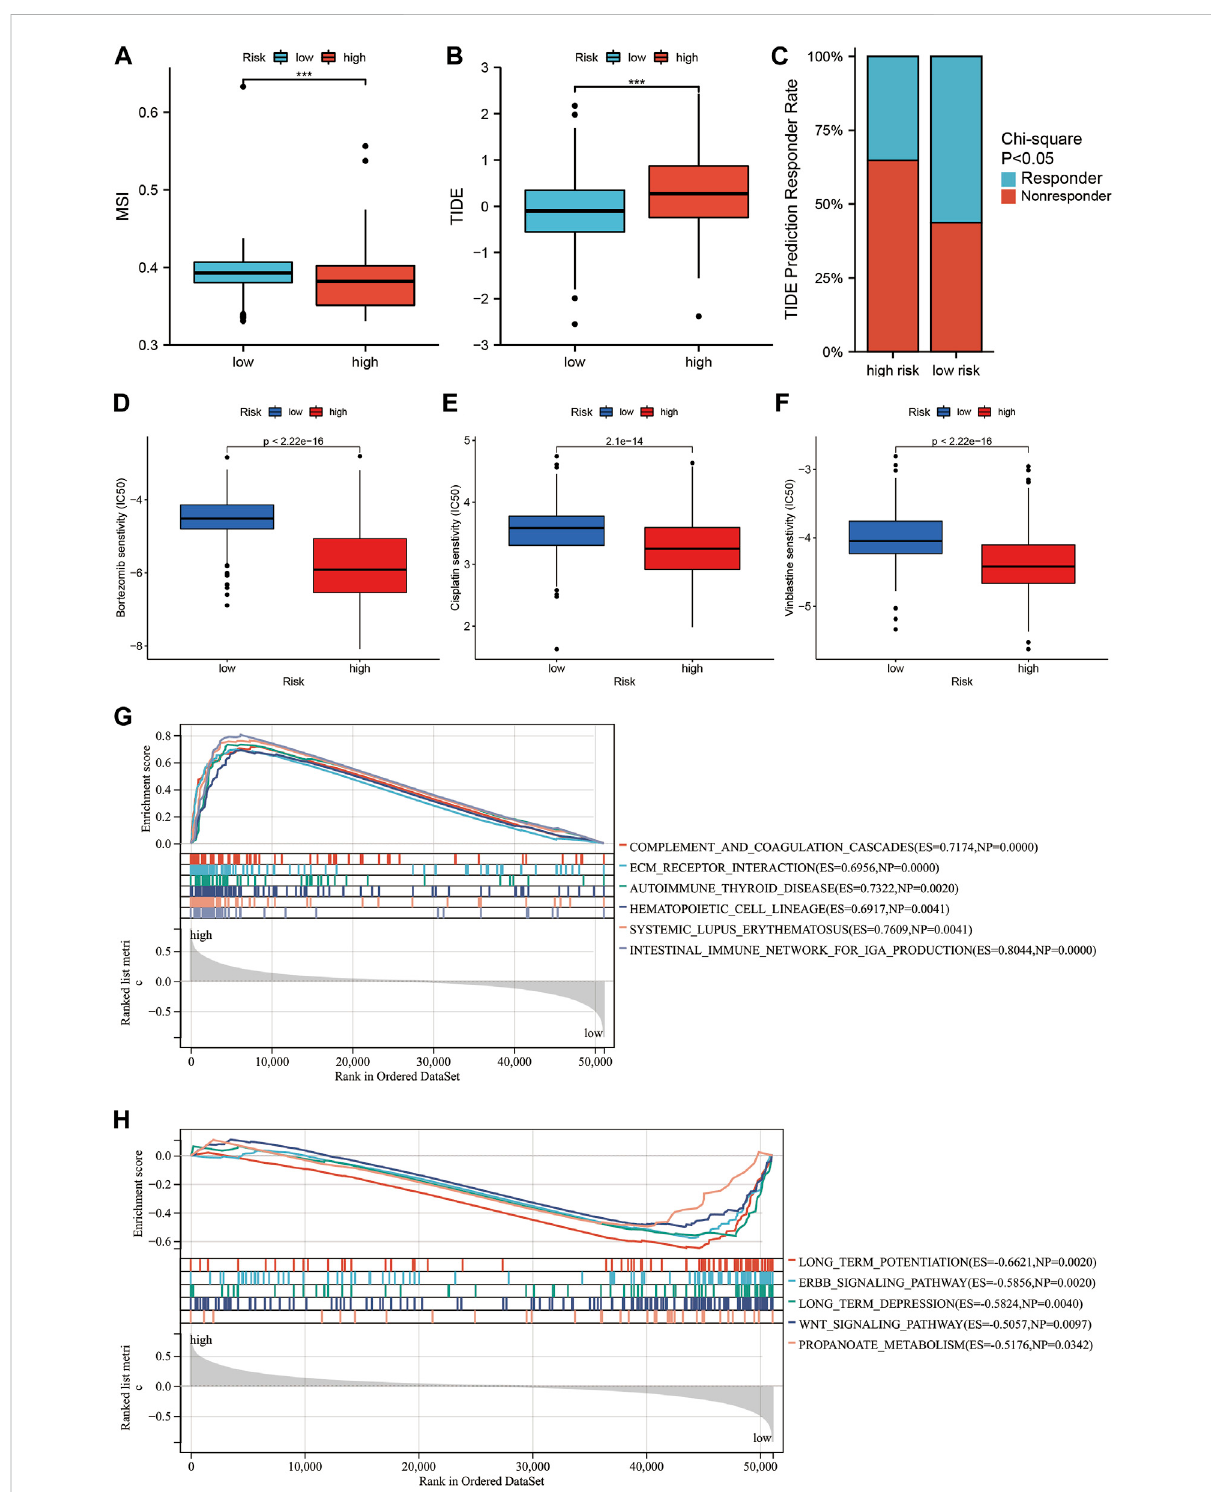
FIGURE 8 Relationship between the SIRT-based signature and drug sensitivity in glioma patients and GSEA. (A) Differences in MSI scores between HRand LRgliomapatientsintheTCGAdatabase. (B) ThedifferenceinTIDEscorebetweenHRandLRgliomapatientsintheTCGAdatabase. (C) Comparison of the percentage of responders to immunotherapy among high and LR glioma patients in the TCGA database. (D – F) Comparison of sensitivity to Bortezomib (D) ,Vinblastine (E) ,andCisplatin (F) inhighandLRgliomapatients inTCGAdatabase. (G,H) Top5KEGGpathways weresigni fi cantly enriched in the TCGA database in the HR group (G) and LR group (H) (* p < 0.05, ** p < 0.01, *** p < 0.001, ns: p >